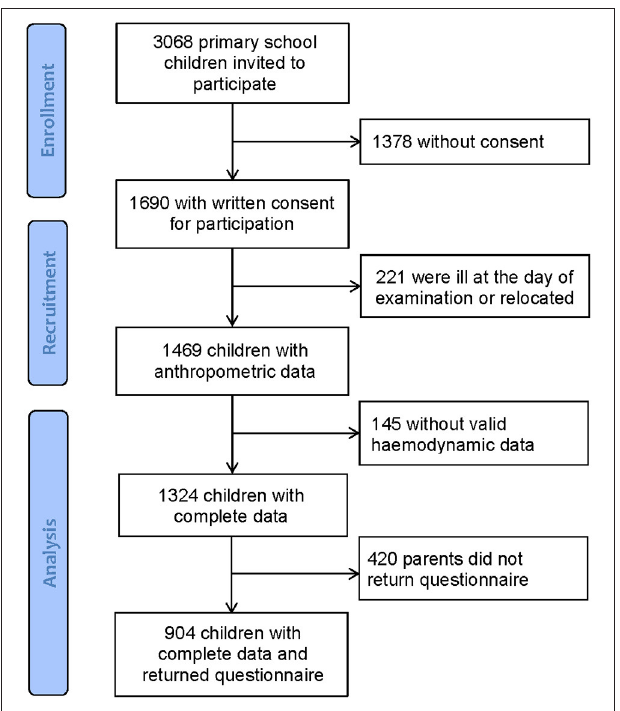
FIGURE 1 | Flow diagram.